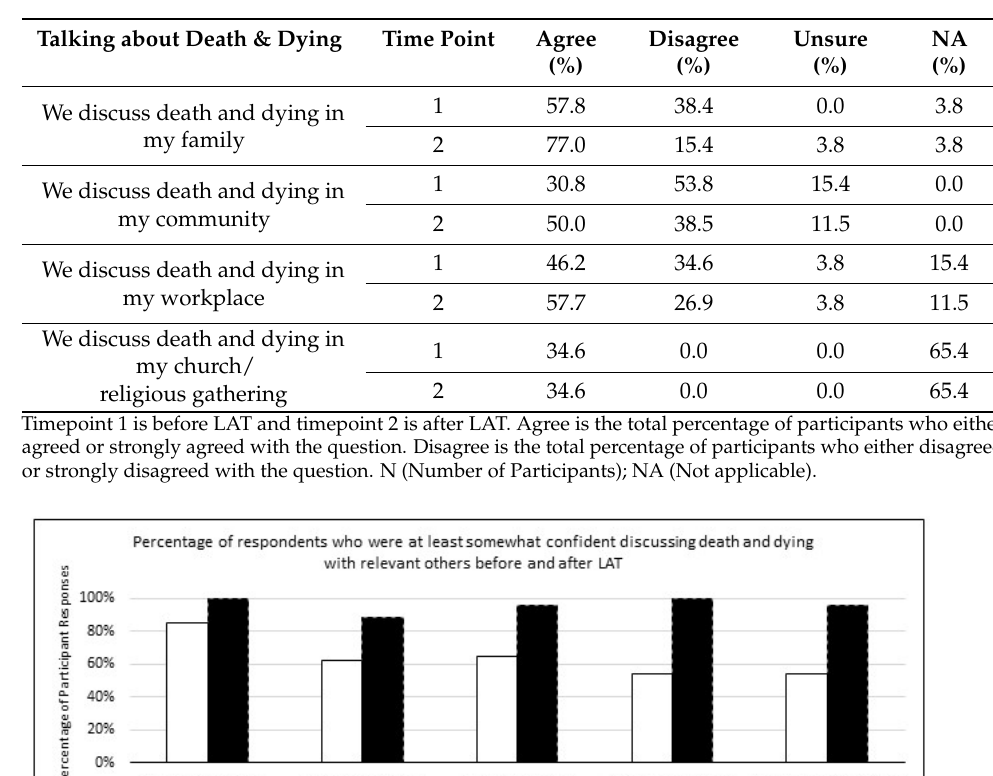
Table 3. Talking about death and dying with others.